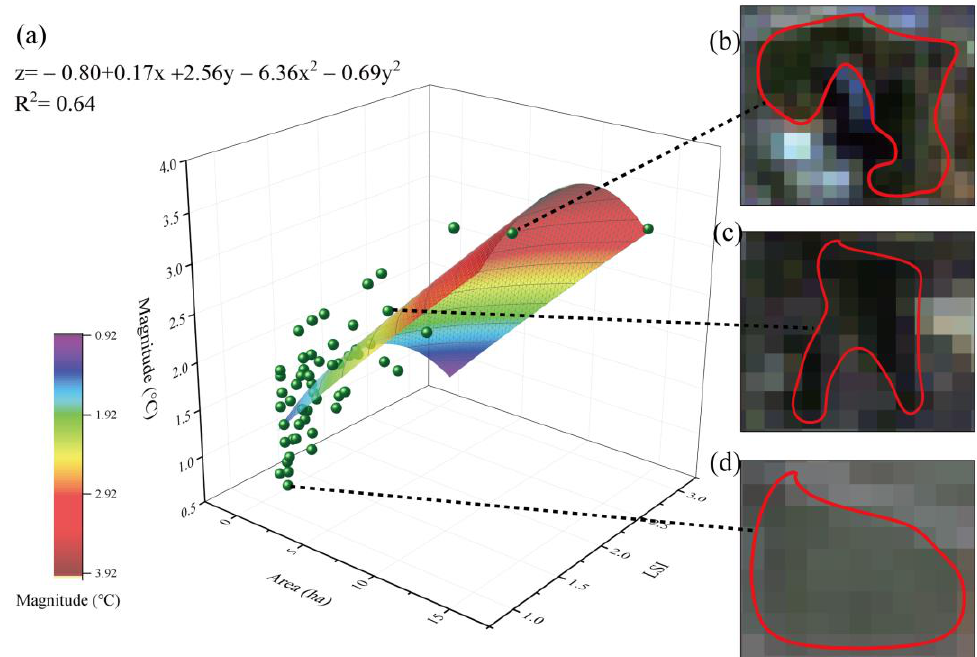
Figure 5. Relationships among the green space area, LSI, and cooling magnitude. ( a ) Function description; ( b ) sample 1, a green space with an area of 9.93 ha and LSI of 1.57; ( c ) sample 2, a green space with an area of 3.56 ha and LSI of 1.52; and ( d ) sample 3, a green space with an area of 1.29 ha and LSI of 1.10.